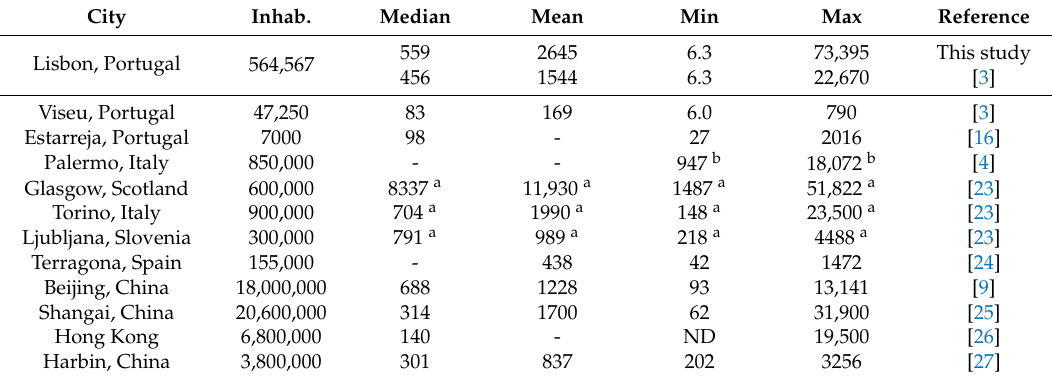
Table 1. Median, mean concentration, and range of polycyclic aromatic hydrocarbons (PAHs) ( µ g kg − 1 ) in urban soils around the world, as well as the number of inhabitants (inhab) in each city. City Inhab.